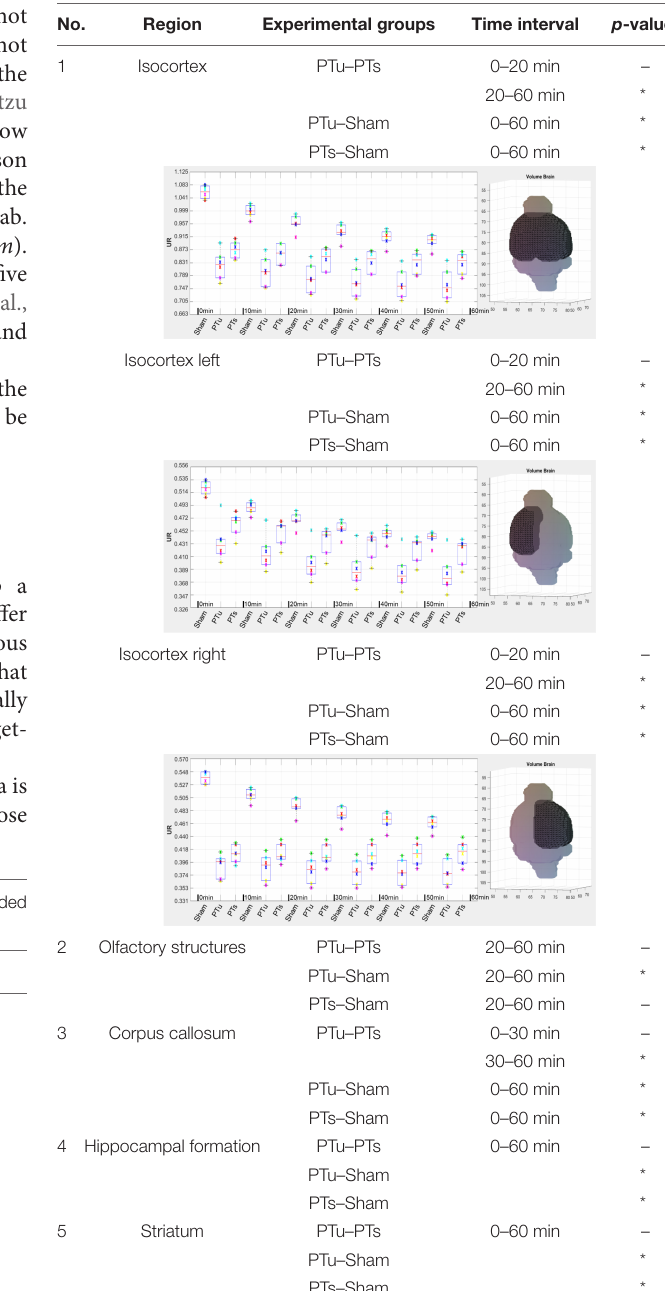
TABLE 2 | Results for the five largest atlas regions of the Wistar MRI atlas (Johnson et al., 2012) of the three-way comparison between healthy control state (Sham), photothrombosis without deep brain stimulation (PT unstimulated, PTu) and photothrombosis including deep brain stimulation (PT stimulated, PTs).